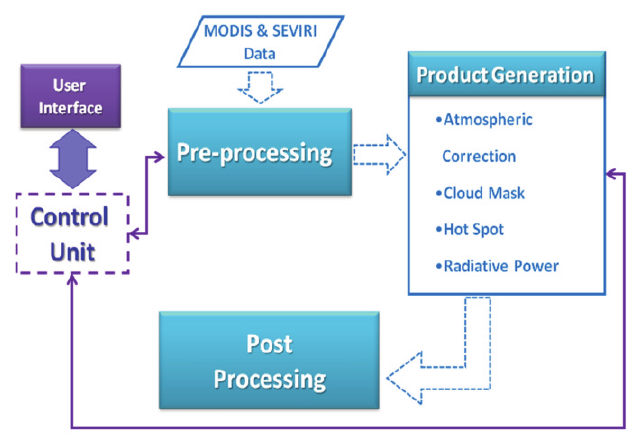
Figure 1. Scheme of the HOTSAT volcano monitoring